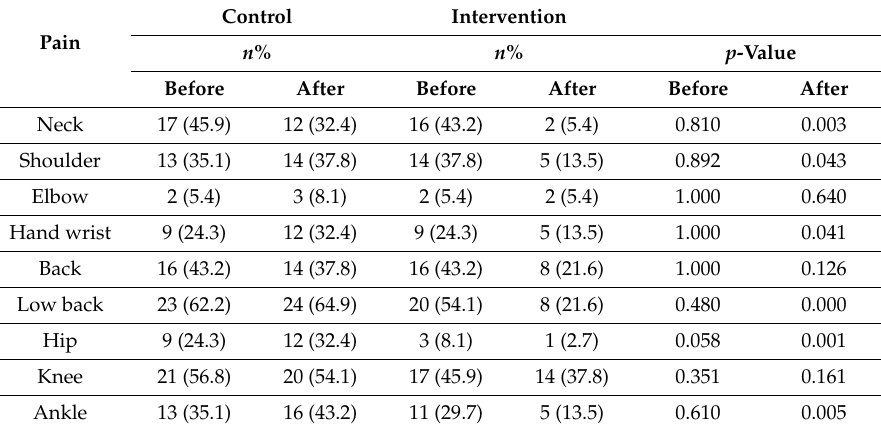
Table 3. The prevalence of pain before and after the intervention in the groups.